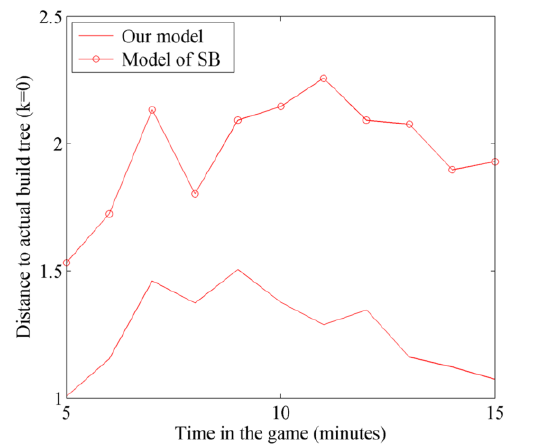
Figure 5. Distance ( for ) in an interval between 5 th up to 15 th minute for PvP match-up with 30% noise for out model and the model of